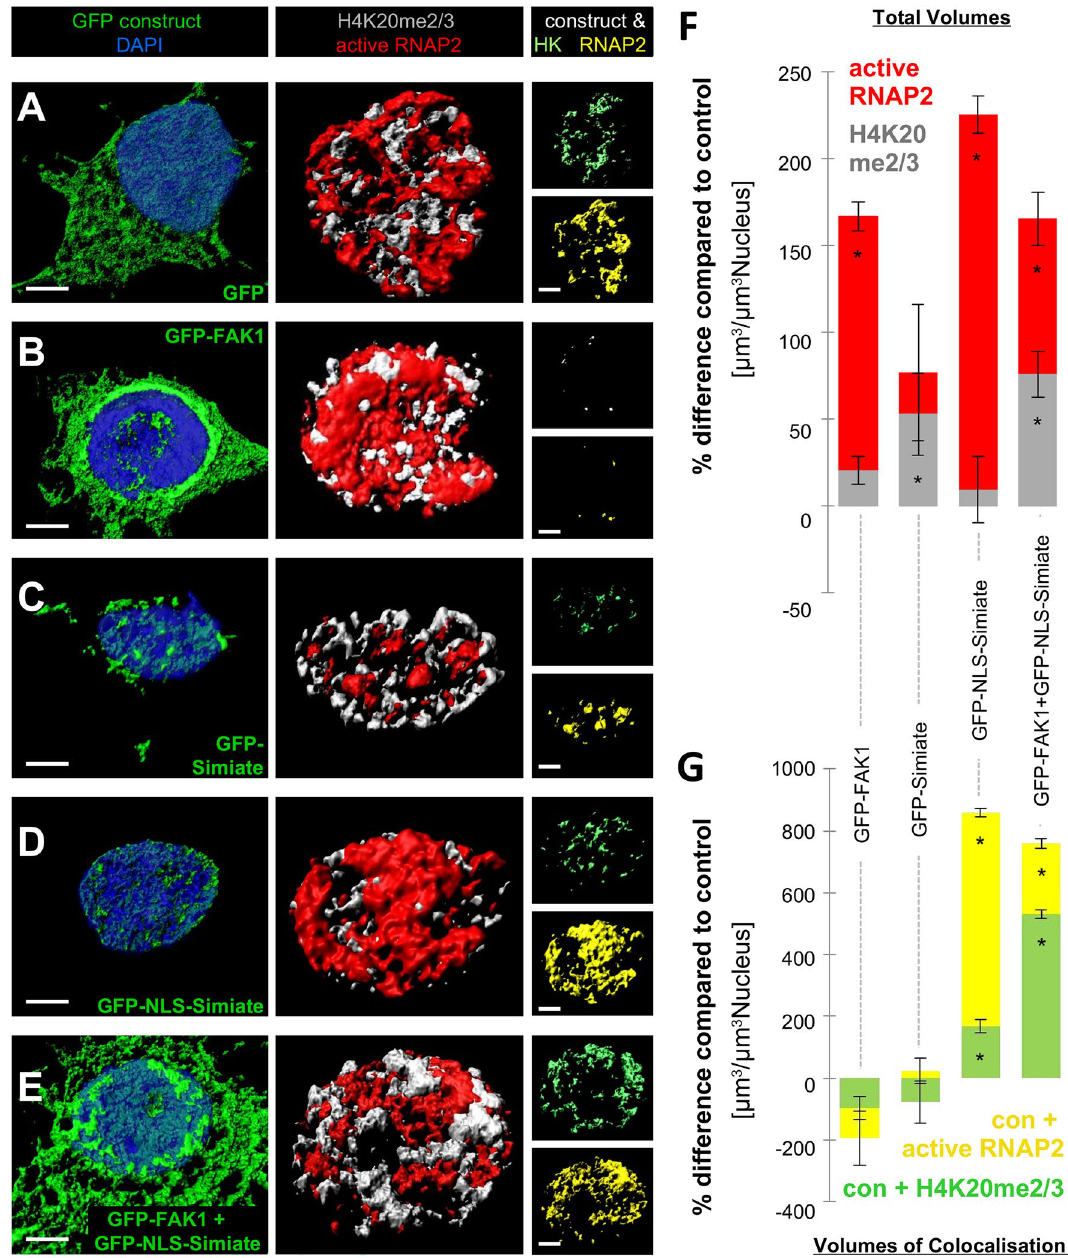
Figure 11. FAK1 and Simiate alter transcription activity. Using Imaris software, 3-dimensional reconstructions of recombinant proteins, active RNAP2, H4K20me2/3 (HK), a marker for inactive chromatin, and proteins colocalising were performed. ( A – E ) Three-dimensional reconstructions of H4K20me2/3 and RNAP2 illustrate alterations in the volumes of both marker proteins following enhanced expression of FAK1 and Simiate. Left column: expression of constructs. Middle column: expression of marker proteins. Right column: intersections of the respective GFP construct and marker proteins. ( F , G ) Quantifications of corresponding protein volumes are shown as deviation from GFP conditions. The graphs illustrate the total volume of active RNAP2 and H4K20me2/3 ( F ) and the amount of colocalisation with GFP constructs ( G ). Since recombinant protein expression in itself may influence gene expression activity, GFP expression serves as control. Statistical details are summarised in Suppl. Table 1. Scale bars: 3 µm. Con: construct (GFP-FAK1, GFP-Simiate and GFP- NLS-Simiate). GFP: n = 8; FAK1: n = 8; Simiate:n = 8; NLS-Simiate: n = 11; FAK1 + NLS-Simiate: n = 8. Colour coding: blue—DAPI, green—GFP or GFP construct, grey—H4K20me2/3, red—active RNAP2; light green— H4K20me2/3 colocalised with GFP constructs, yellow—active RNAP2 colocalised with GFP